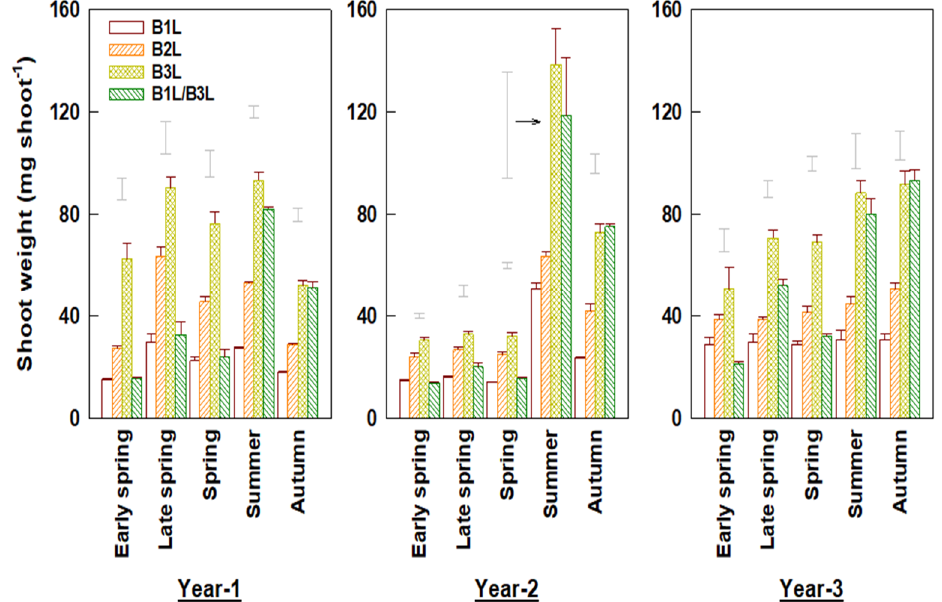
Figure 1. Weight per shoot for plants harvested under different standards in early and late spring, summer, and autumn over three experimental years (means ± standard errors, n = 4). Single bars without data points located above columns are LSD values indicative of significant ( p < 0.05) differences between harvest standards in the specified